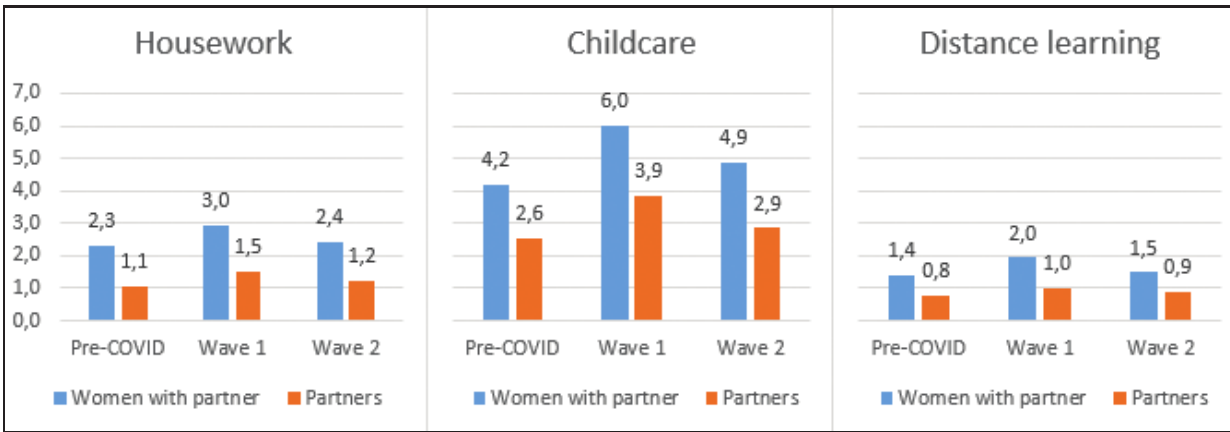
Figure 2 Hours of housework, childcare, and devoted to children’s distance learning before the emergency, during the first and second waves of